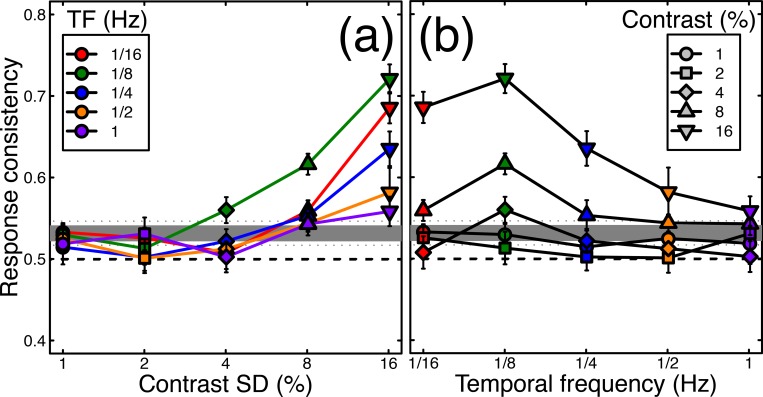
Response consistency across two passes through the experiment.The same data are plotted in both panels, as a function of modulation contrast (a) or temporal frequency (b). In each panel, the thick grey line represents the baseline (no modulation) condition, colours represent different temporal frequencies, and symbol types represent different contrasts. All data points are averaged across participants, with error bars indicating ±1SE of the mean. The dashed horizontal line at y = 0.5 indicates a theoretical baseline in the absence of any response bias or eye dominance effects.